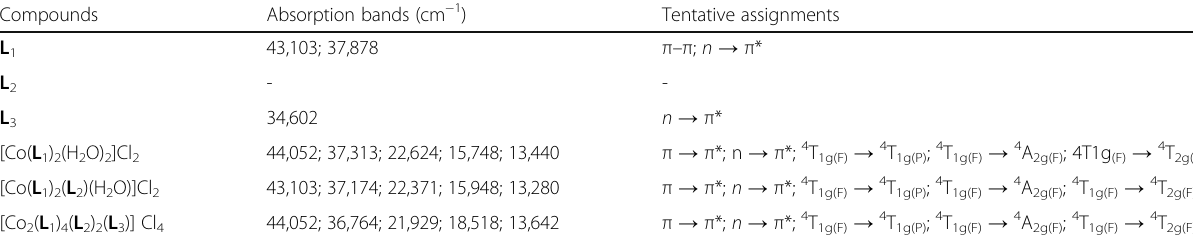
Table 3 Electronic spectral data of the salt and complexes Compounds Tentative assignments